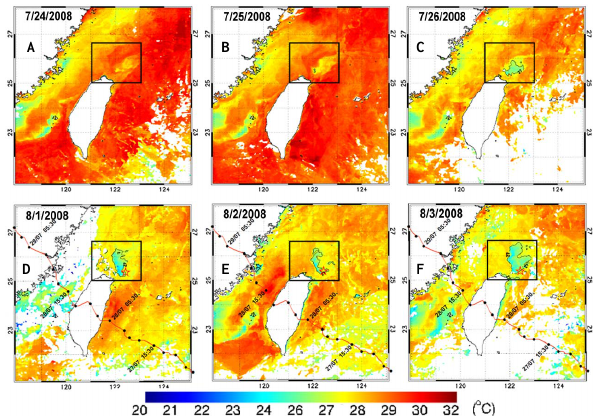
Fig. 1. Study area (blue box, sampling location: a red star) and track (red line in panel D ) of typhoon Fengwong in the southern East China Sea. AVHRR satellite images on 24, 25 and 26 before the typhoon and 1, 2 and 3 August after the typhoon. The area of cold water patch (e.g. SST < 27 ◦ C) shown in the blue box on 24 July (A) is significantly smaller than that on 2 August (E) . The red lines represent the typhoon moving track of